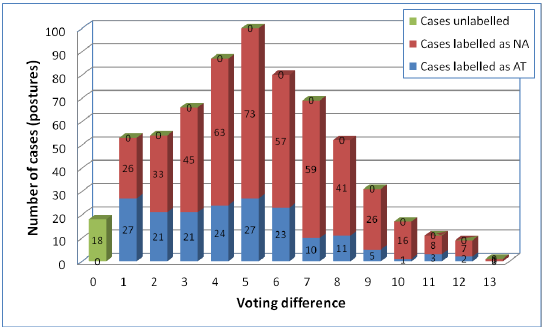
Fig. 2. Distribution of the voting according to class labeling confidence. Reproduced from [10].